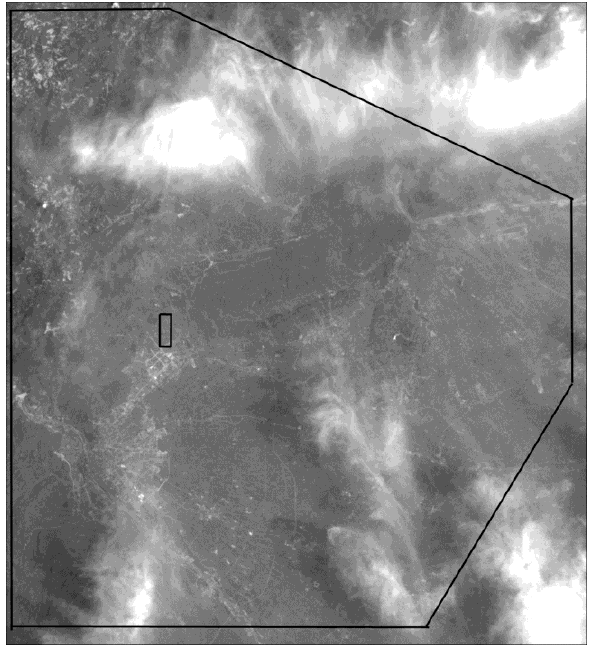
Figure 4. ALOS image of Hongkou, Sichuan, China